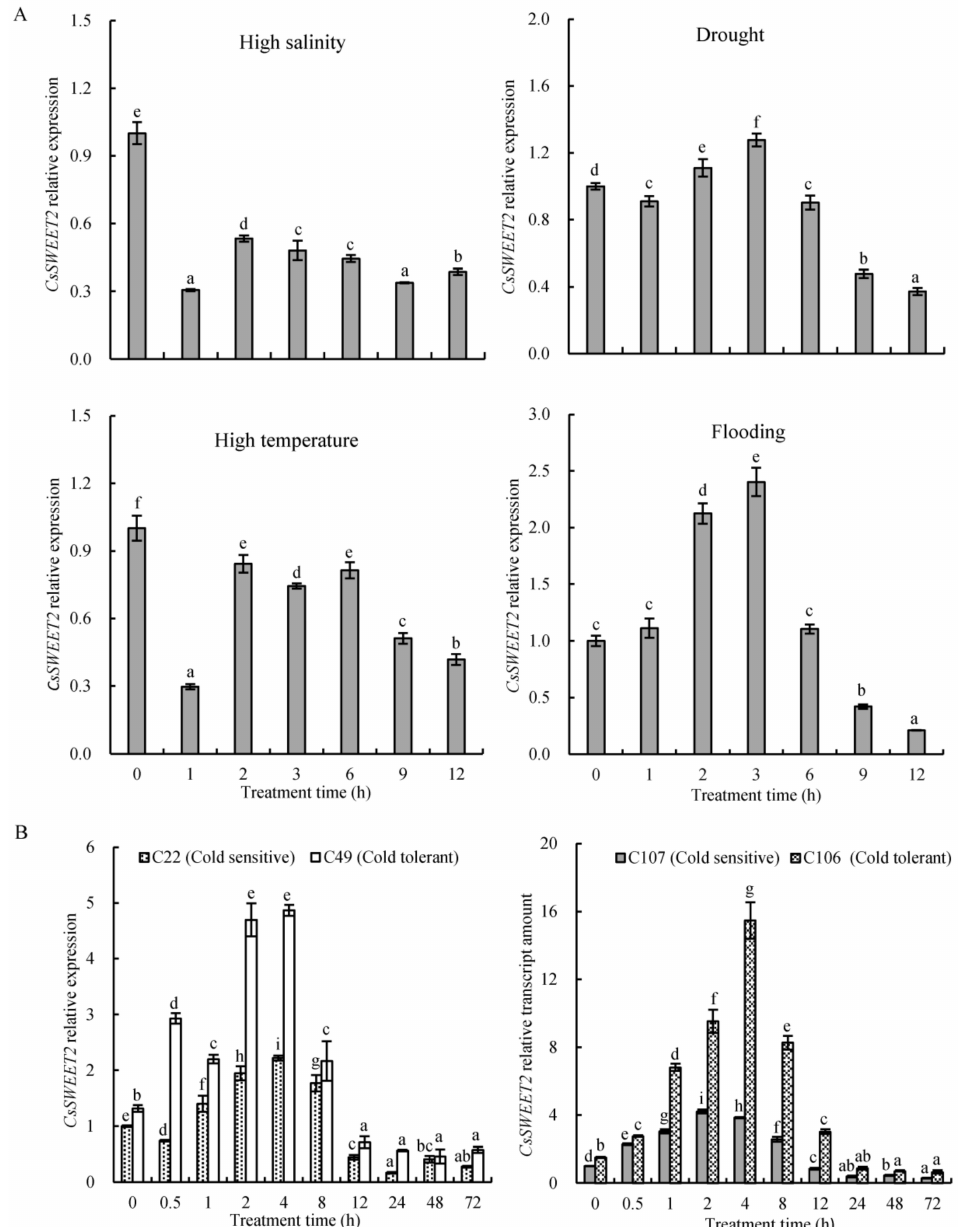
Figure 5. Expression profiles of CsSWEET2 in the leaves of cucumber seedlings under abiotic stresses. ( A ) Seedlings (inbred line C49) at the 3–4 true leaf stage were used for subsequent treatments involving high salinity (200 mM NaCl), drought (10% polyethylene glycol 6000), high temperature (40 ◦ C), and flooding. ( B ) Seedlings (inbred lines C22, C49, C106, and C107) at the 3–4 true leaf stage were used for subsequent cold-stress (10 ◦ C) treatment. The relative expression levels of CsSWEET2 were detected via quantitative real-time PCR (qRT-PCR), and the cucumber actin gene was used as a reference for normalization of the expression data. The data are presented as the means ± SDs of three replicates. The different letters above the bars indicate significant differences ( p <